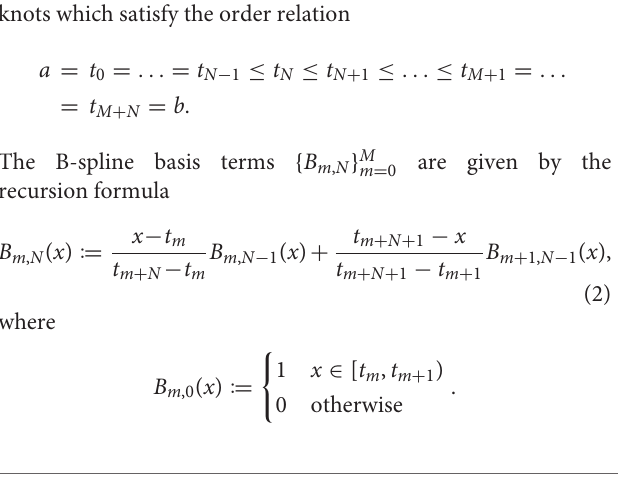
N N N , ... , M , and t i 0 for i 0, ... , N 1, t i ( i 1) / ( M 2) for i = = − = − + − + =